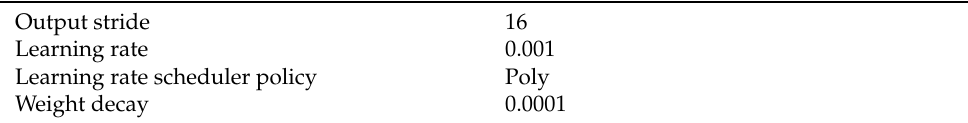
Table 1. Training parameters in DeepLab